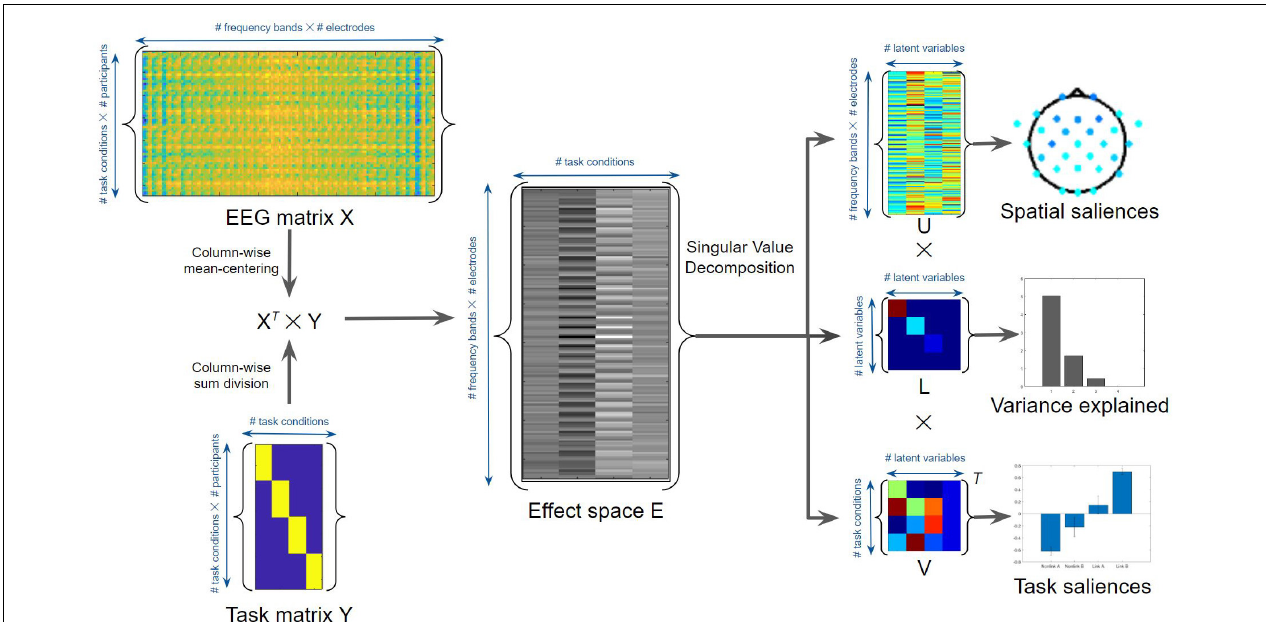
FIGURE 4 | Task Partial Least Squares (PLS) algorithm for the average EEG time-frequency power. See text for details.